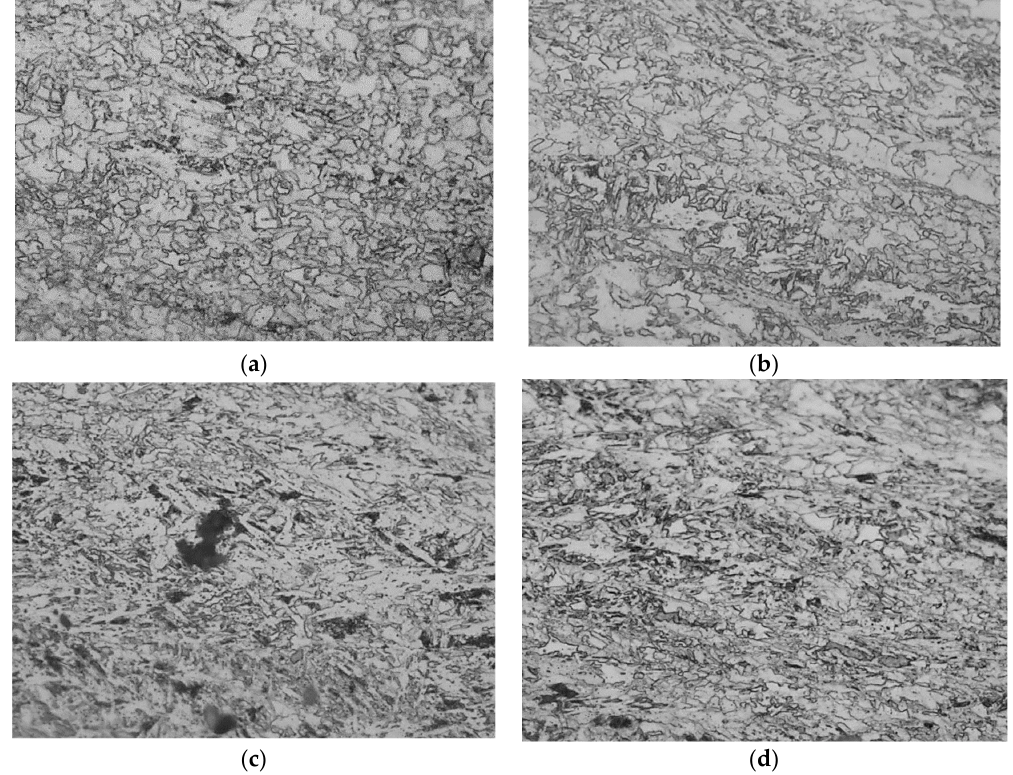
Figure 5. Metallurgical structures under open-door furnace cooling, 500x: ( a ) S1; ( b ) S2; ( c ) S3; ( d ) S4.